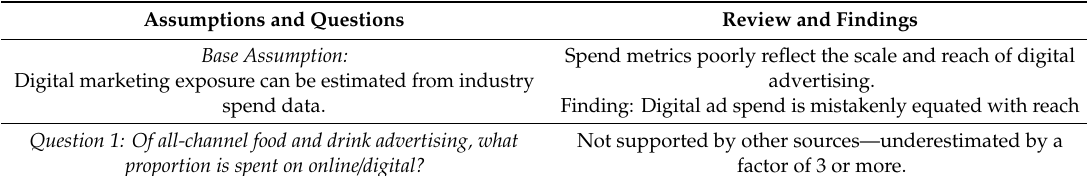
Table 1. Summary of UK Government Model’s assessment of children’s digital advertising exposure to unhealthy food, calculated from ad